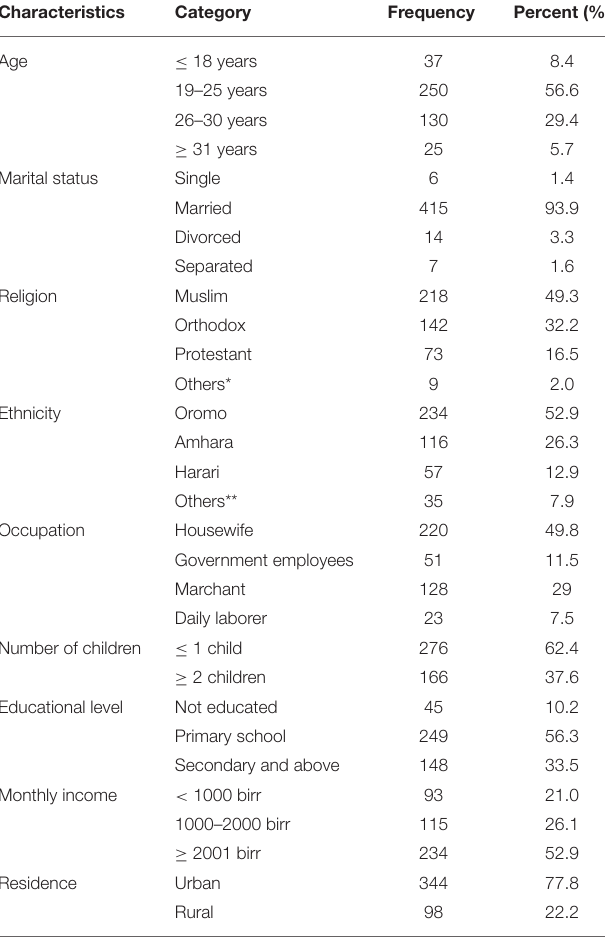
TABLE 2 | Socio-demographic characteristics of respondents attending ANC in a University Hospital in Eastern Ethiopia, 2021 ( n = 442). Characteristics